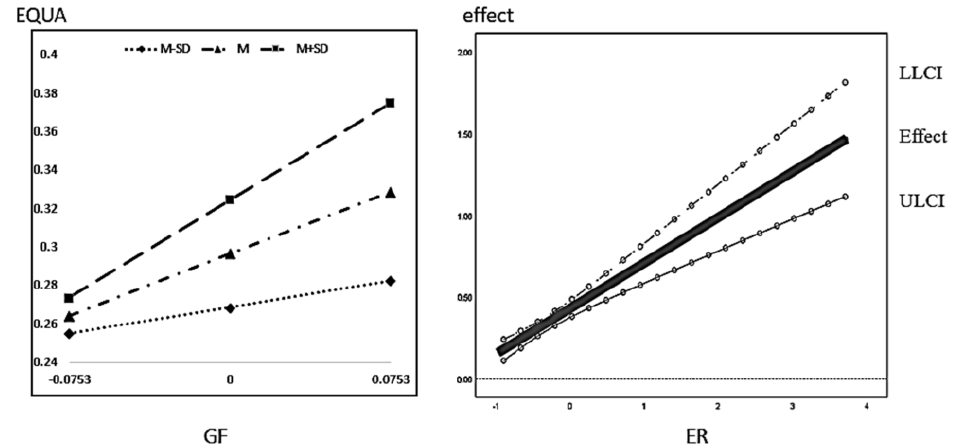
Figure 4. Total effect of green finance on economic quality development under the role of environ- mental regulation.